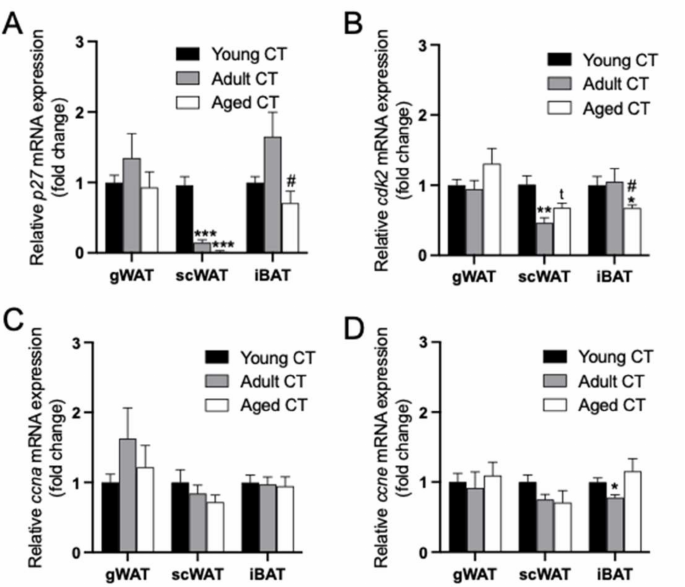
Figure 3. Changes induced by aging on the mRNA expression of p27 ( A ); cdk2 ( B ); ccna ( C ); ccne ( D ) within gWAT, scWAT and iBAT from young, adult and aged (2-, 6- and 18-month-old) CT female mice. Data (mean ± SEM) are expressed as fold change of Young CT, considered as 1. * p < 0.05, ** p < 0.01, *** p < 0.001 vs. young CT; # p < 0.05 vs. adult CT; t p = 0.07 vs. Young CT ( n =